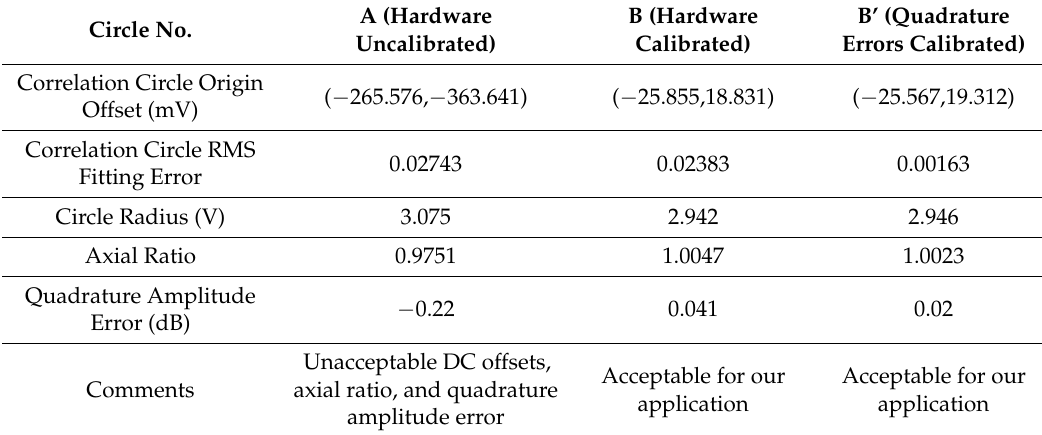
Table 2. Specifications of the correlation circles A, B, and